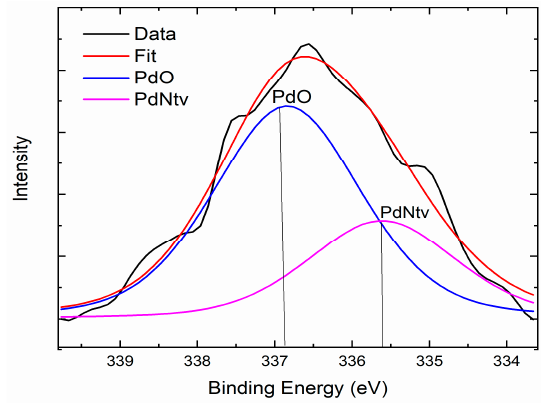
Figure 14. XPS (deconvoluted Pd3d 5/2 peak) of catalyst after reaction at 450 °C.